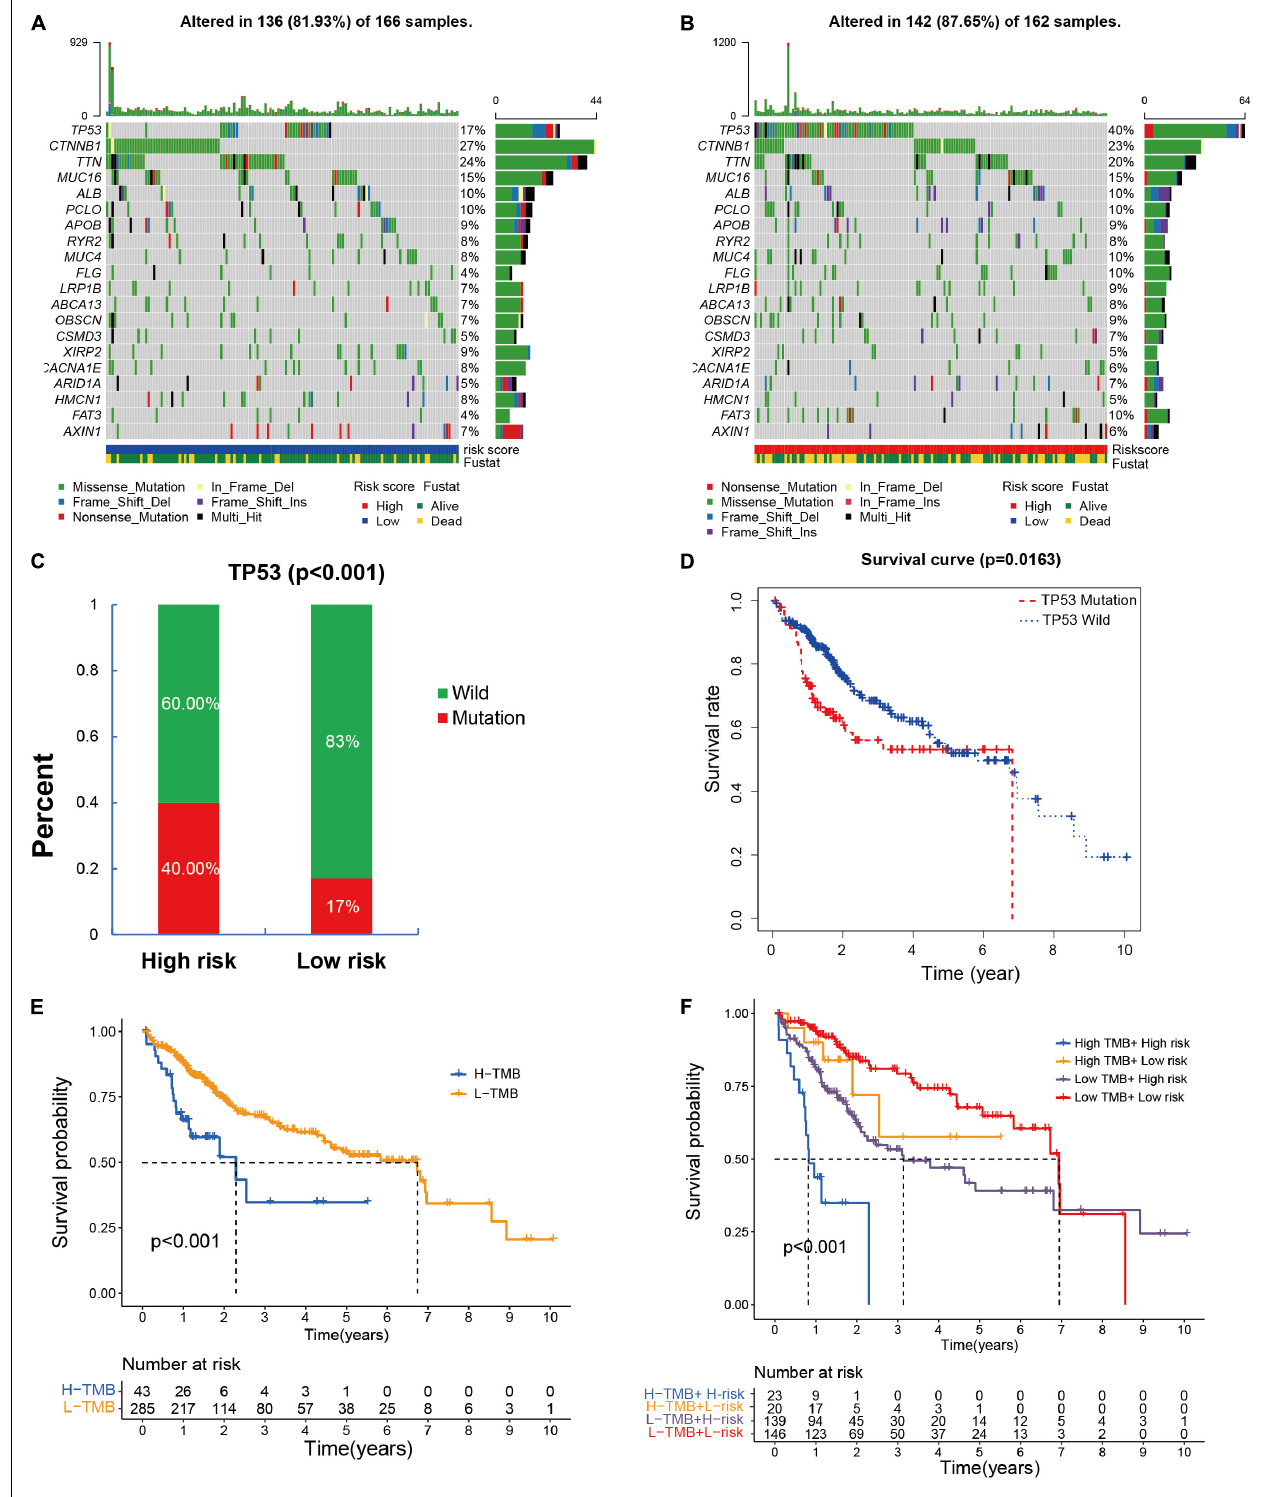
FIGURE 9 | The association between risk signature and single-nucleotide variant in HCC. (A,B) The top 20 genes mutations in high- and low-risk groups based on the TCGA entire cohort; (C) the occurrence probability of TP53 mutations in high- and low-risk groups. (D) Kaplan–Meier survival analysis according to the mutation state of TP53. (E,F) Kaplan–Meier survival analysis based on the TMB and risk signature.